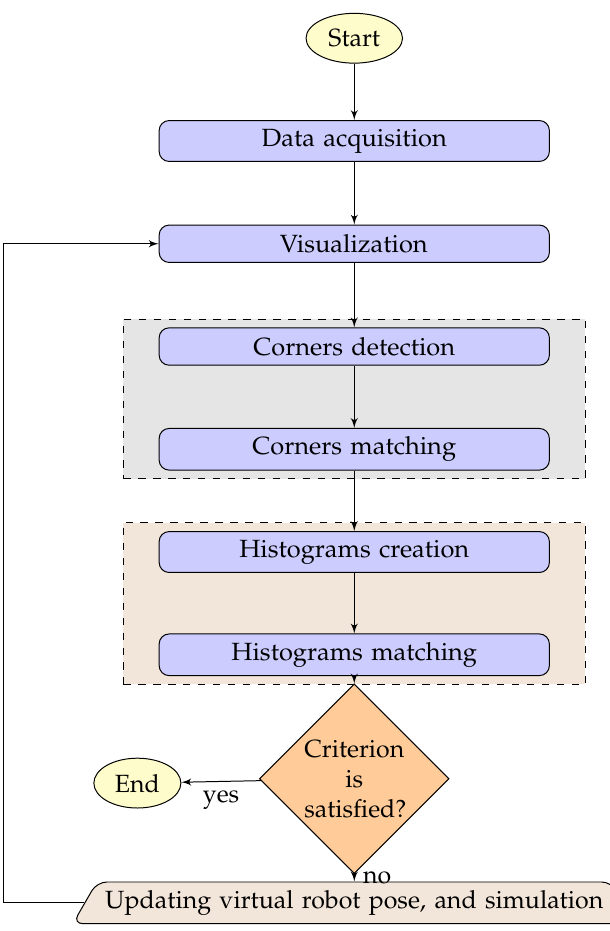
Figure 4. A brief overview of the proposed